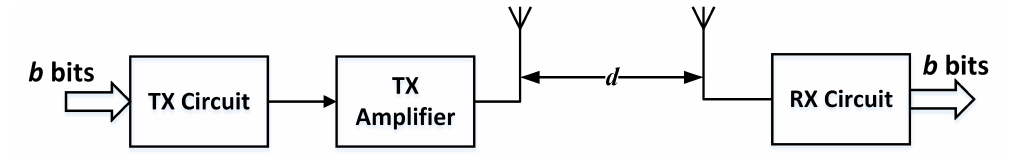
Figure 18. Wireless transmission